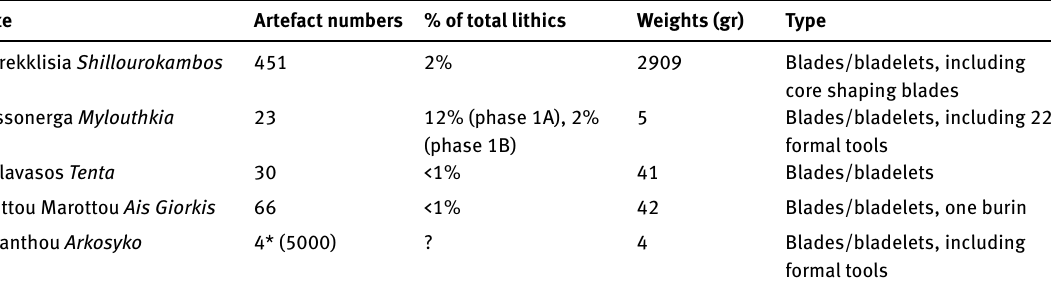
Table 2. The table summarises the quantities and weights of obsidian artefacts recovered from each of the five Early Aceramic Neolithic archaeological sites discussed in the